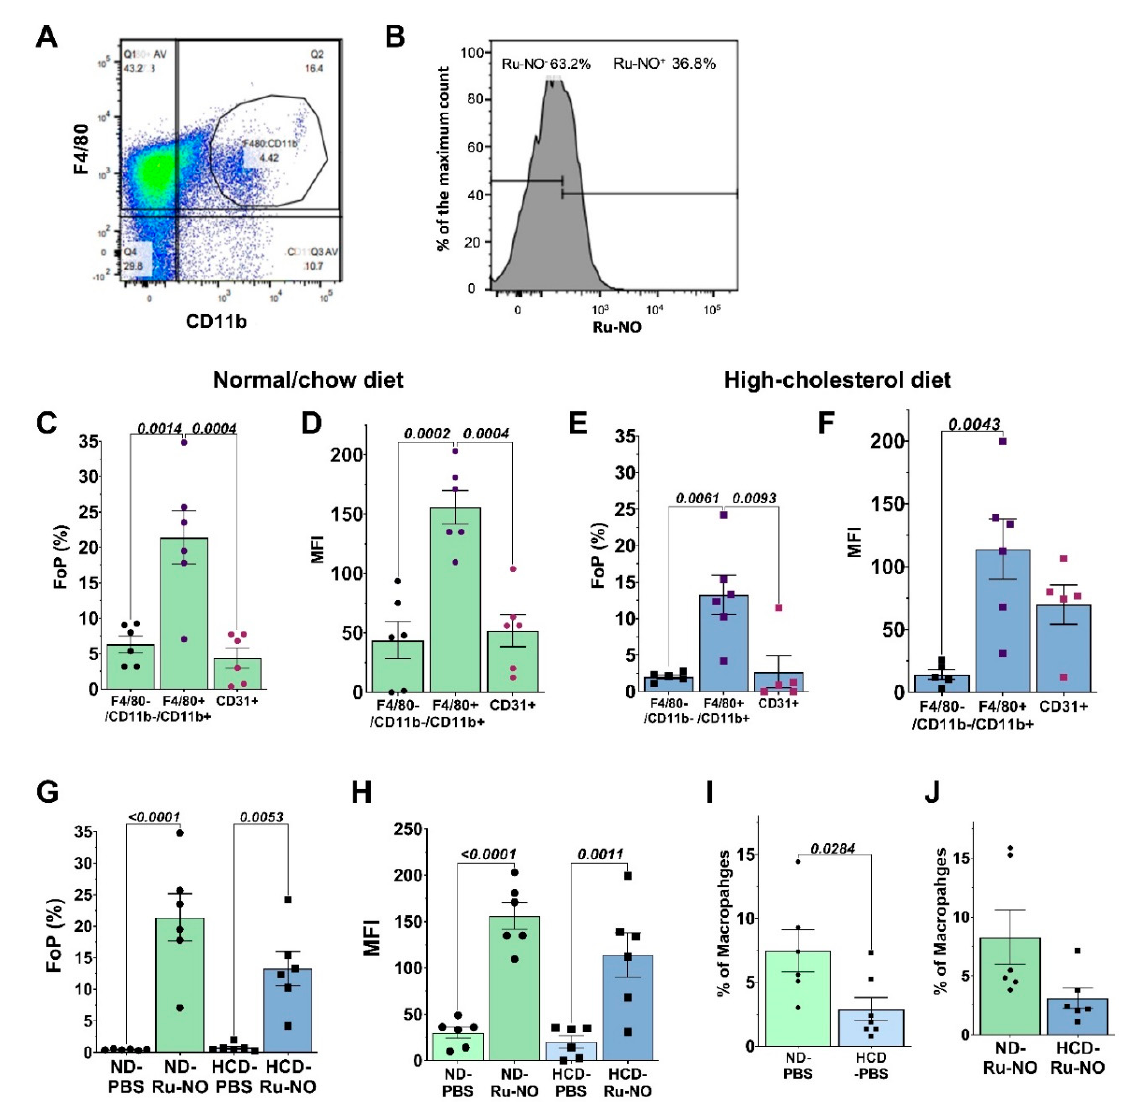
Figure 5. Ex vivo uptake of Ru-NO by macrophages in aortic cell suspensions from atherosclerotic mice. ( A ) Representative plot for the distributions of aortic cell suspensions incubated with antibodies against CD11b and F4/80 markers. ( B ) Representative histogram demonstrating the shift in Ru-NO fluorescence in aortic cell suspensions. ( C ) Frequency of parental (FoP) and ( D ) mean fluorescence intensity (MFI) for Ru-NO fluorescence in myeloid cells (CD11b + F4/80 − ), macrophages (CD11b + F4/80 + ) and endothelial cells (CD31 + ) in aortic cell suspensions from chow-fed mice. ( E ). FoP and ( F ) MFI for Ru-NO fluorescence in aortic cell suspensions in high-cholesterol diet (HCD)-fed group. ( G ) FoP and ( H ) MFI in CD11b + F4/80 + macrophages comparing aortic cell suspensions from chow and HCD-fed groups with ex vivo addition of PBS or Ru-NO. Proportion of macrophages in all viable cells that had been incubated with ( I ) PBS and ( J ) Ru-NO. Mean ± SEM, p values derived from one-way ANOVA with Tukey post-hoc test for multiple comparisons across different groups (n = 5–6